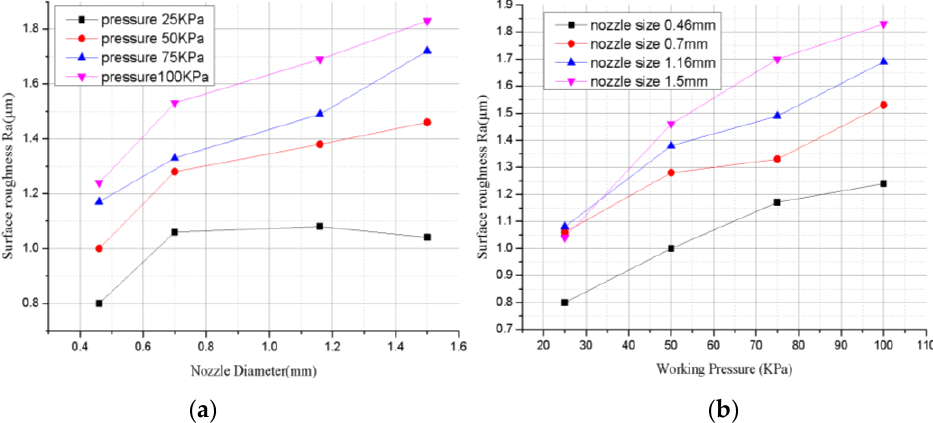
Figure 5. Experimental result of surface roughness for Al 2 O 3 , ( a ) nozzle diameter, ( b ) working pres- sure.